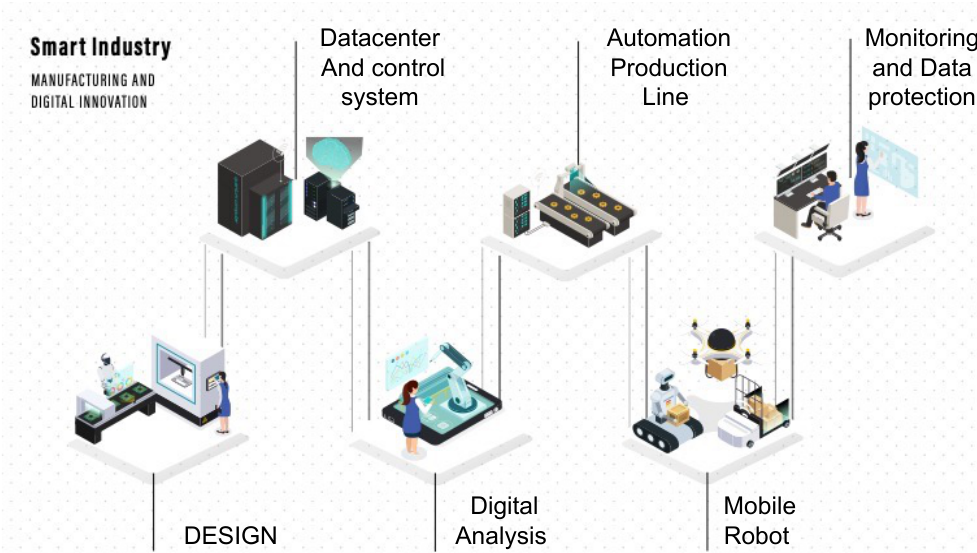
Figure 1. Industry 4.0